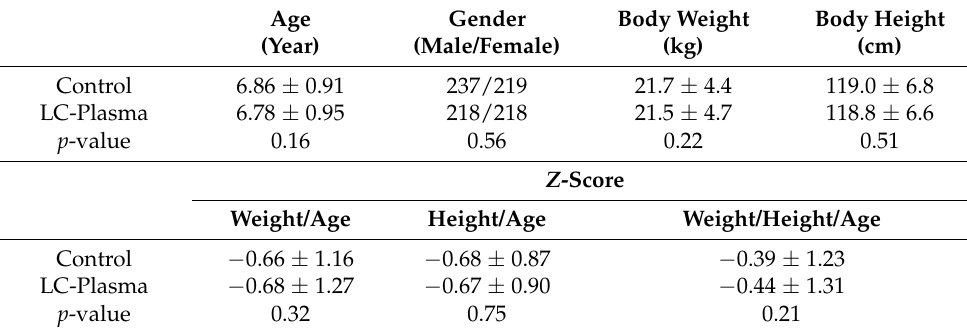
Table 1. Background information of participants at